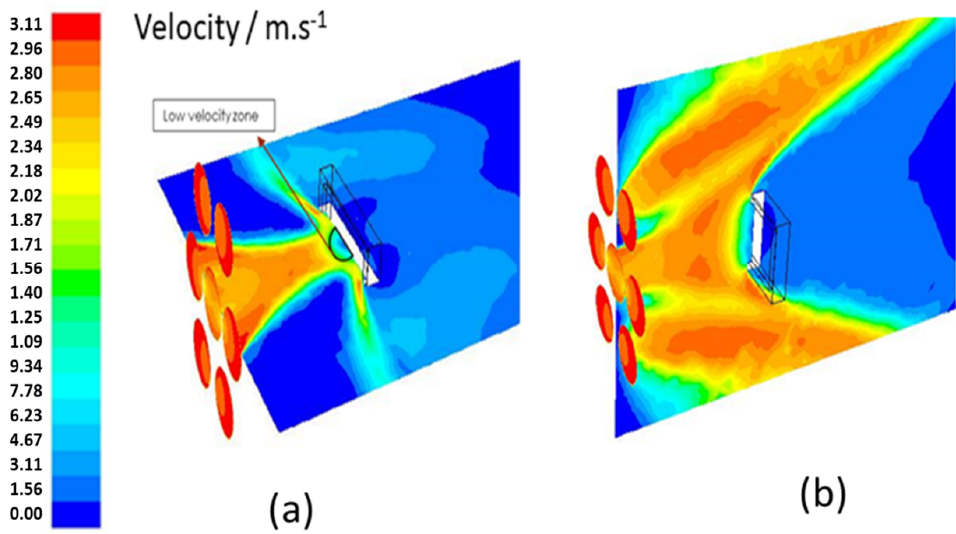
Figure 9. Velocity contours across the cross-section of the airflow domain. ( a ) Velocity contours across the airflow field with the stagnant zone marked ( b ) Cross−section of velocity contours across the domain.